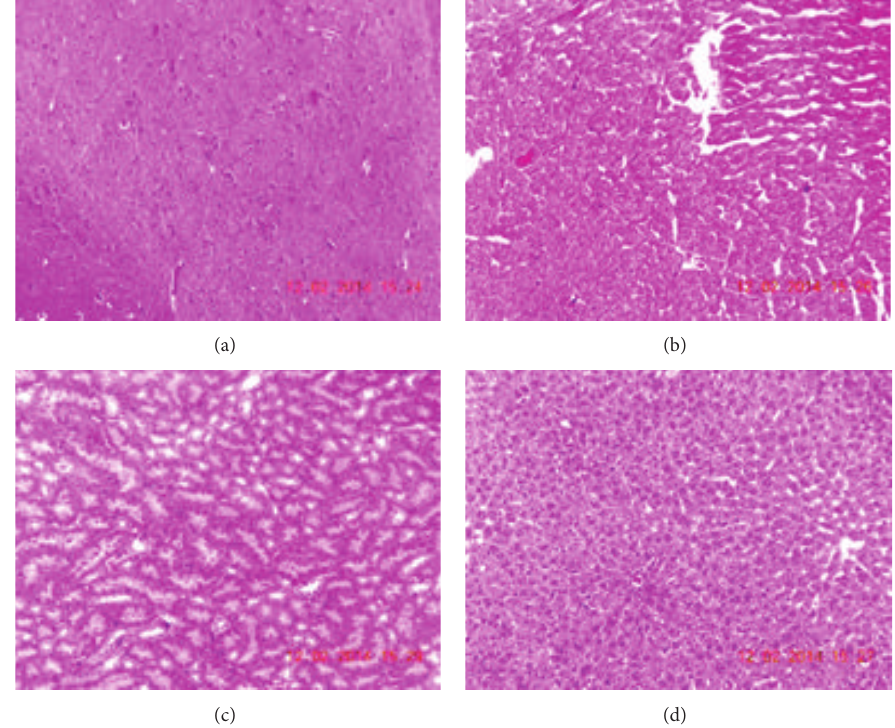
Figure 10: Photomicrograph of (a) brain, (b) heart, (c) kidney, and (d) liver of group treated with NLCs